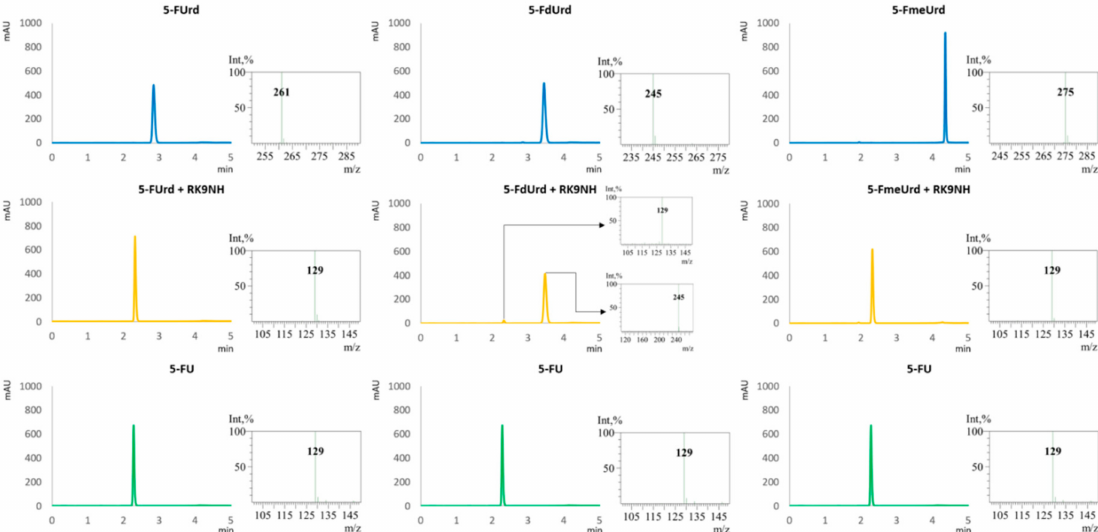
Figure 7. An example of the UV chromatograms ( left ) and MS-spectra corresponding to the peaks ( right ) of substrate standards (blue), nucleoside hydrolase RK9NH enzymatic reaction mixtures (yellow) and product standards (green). The MS spectra are consistent with [M-H] − detection of molecular ions. 5-FUrd: 5-fluorouridine, 5-FdUrd: 5-fluoro-2 (cid:48) -deoxyuridine, 5-FmeUrd: 5-fluoro-2 (cid:48) - O -methyluridine, 5-FU: 5-fluorouracil. Table 2. Substrate specificity of hydrolysis by RK9NH. Conversions were defined as a percentage of the mass amounts of corresponding heterocyclic base (product) in the hydrolysis reaction mixture. The experiments were performed at least 3